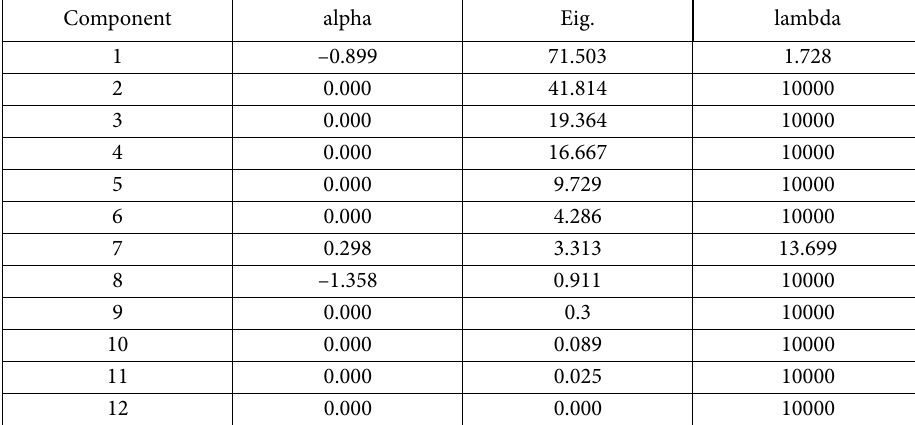
Table 8. Posterior estimates of principal components of explanatory variables in case of Slovak Republic (source: own results)